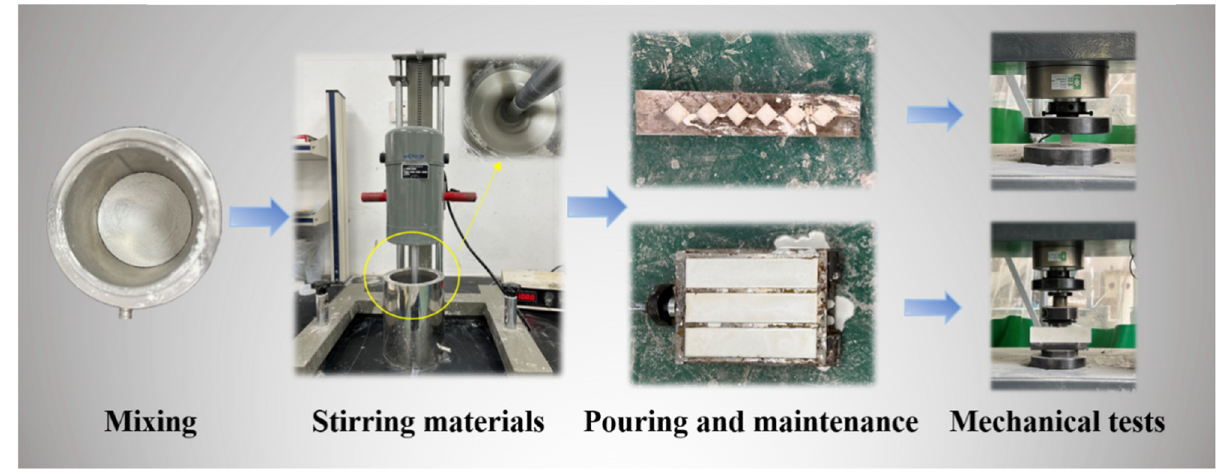
Figure 1: A picture of the